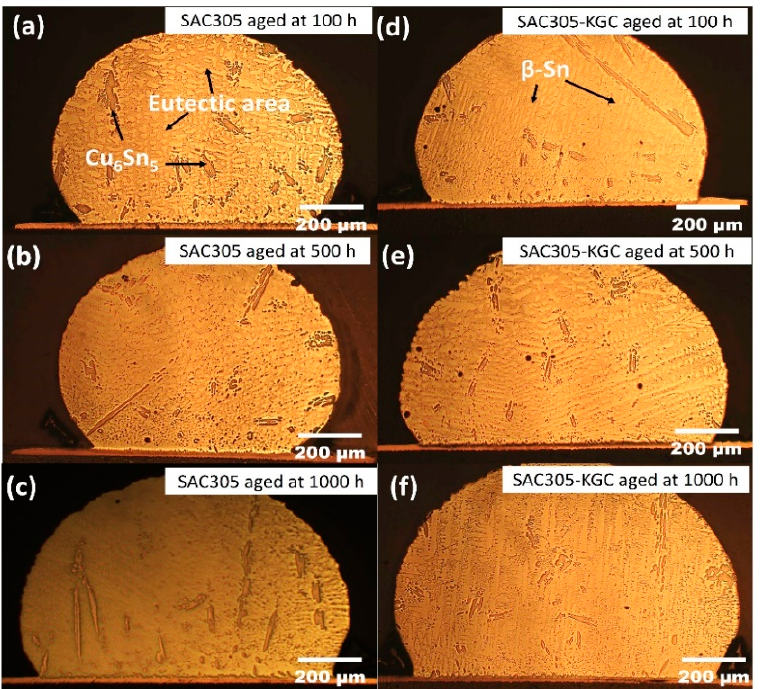
Figure 2. Microstructure formation at the bulk solder after isothermal ageing at 85 °C. Non-reinforced SAC305 solder at ( a ) 100 h, ( b ) 500 h, ( c ) 1000 h and SAC305-KGC composite solder at ( d ) 100 h, ( e ) 500 h, ( f ) 1000 h.